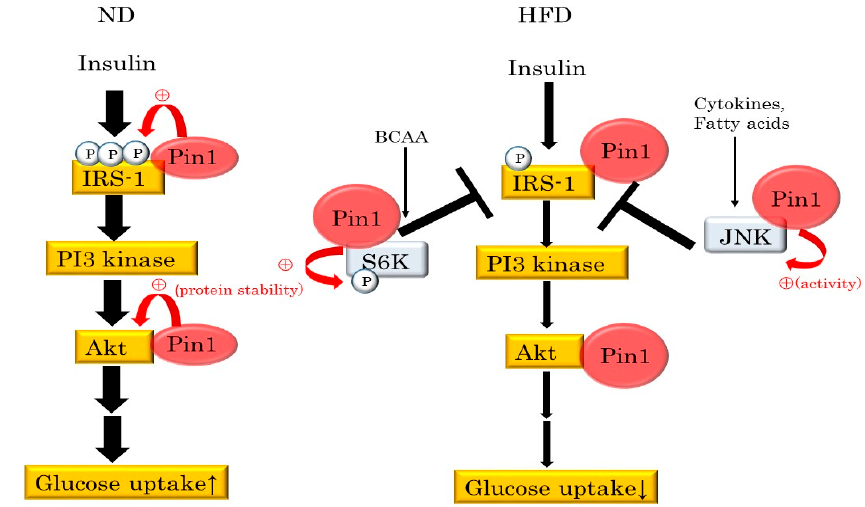
Figure 4. Pin1 has biphasic effects on insulin signaling. Pin1 associates with IRS-1 and